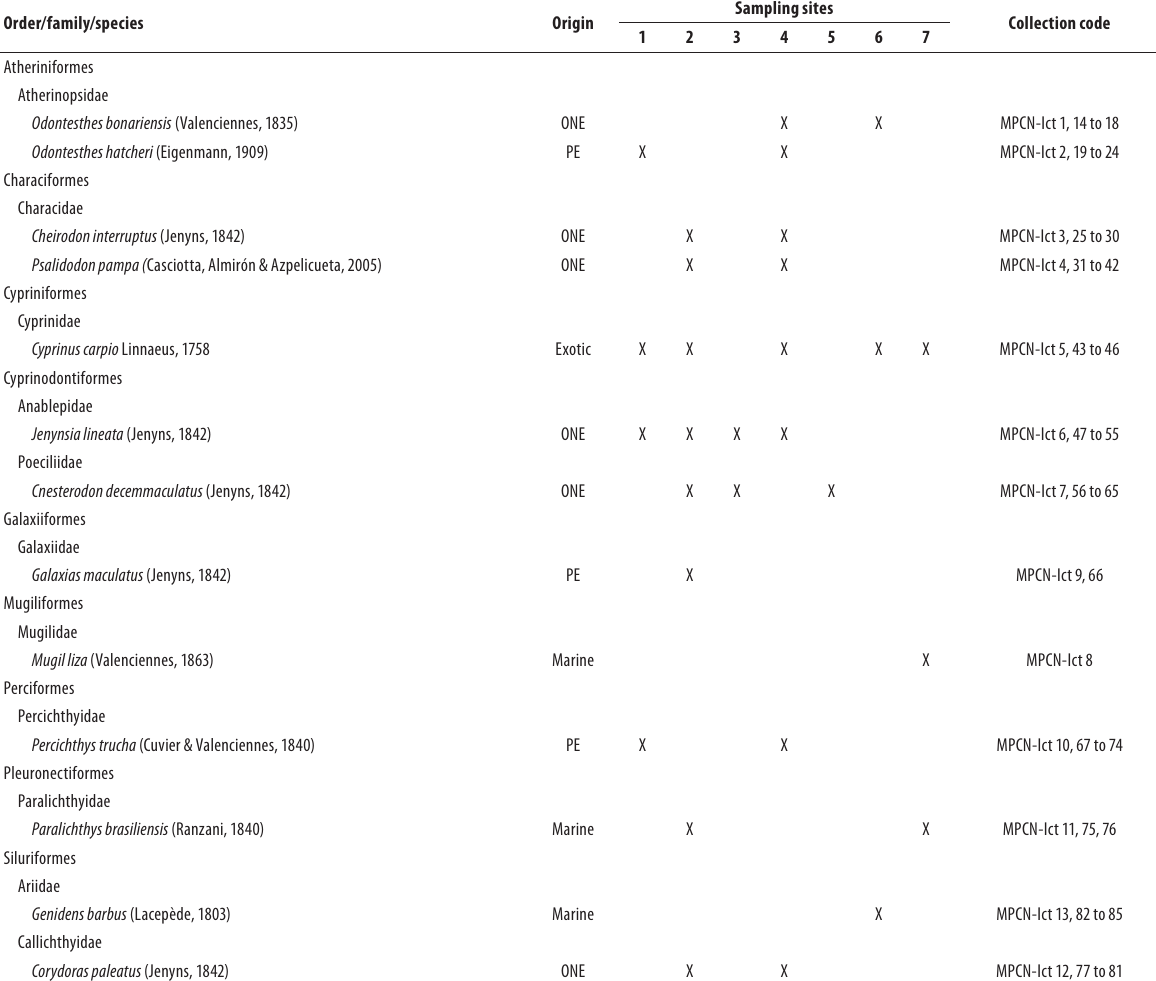
Table 2. List of species collected in the lower course of the Negro river drainage, Argentina. Abbreviations: ONE, other Neotropical ecore- gion; PE, Patagonia ecoregion.